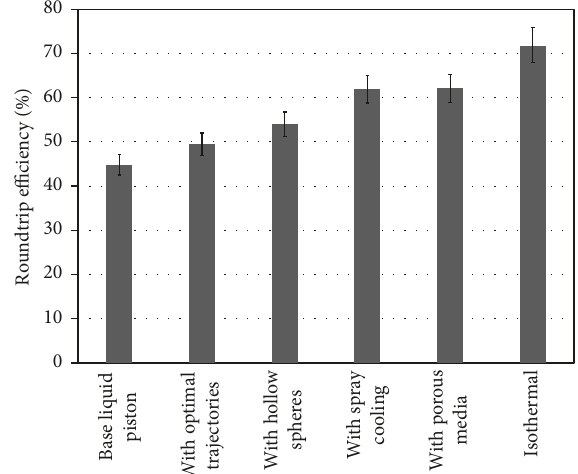
Figure 11: Roundtrip efficiency of liquid piston based OCAES with various heat transfer enhancement